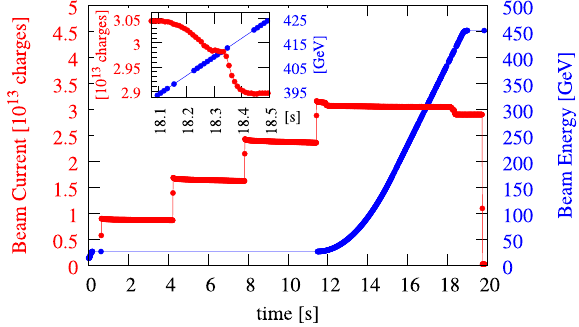
FIG. 2. Example of the SPS cycle for LHC beams: beam current (red curve, left vertical axis) and energy (blue curve, right vertical axis). It should be noted that the shown profile of beam current ends with a dump event and not with extraction; moreover, magnet ramp down is omitted. The inset shows the effect of both horizontal and vertical scrapings.